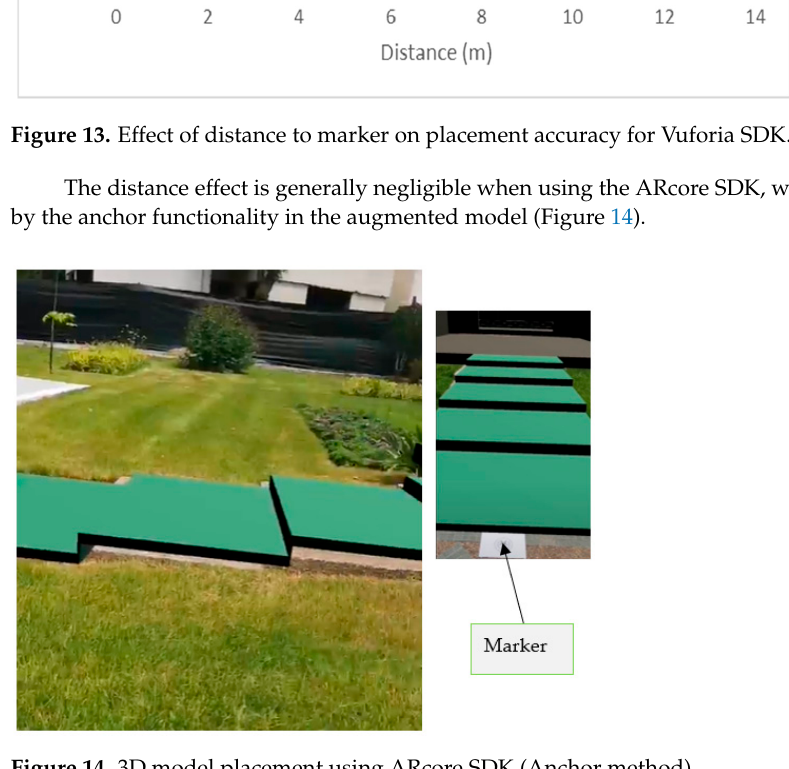
Figure 14. 3D model placement using ARcore SDK (Anchor method).